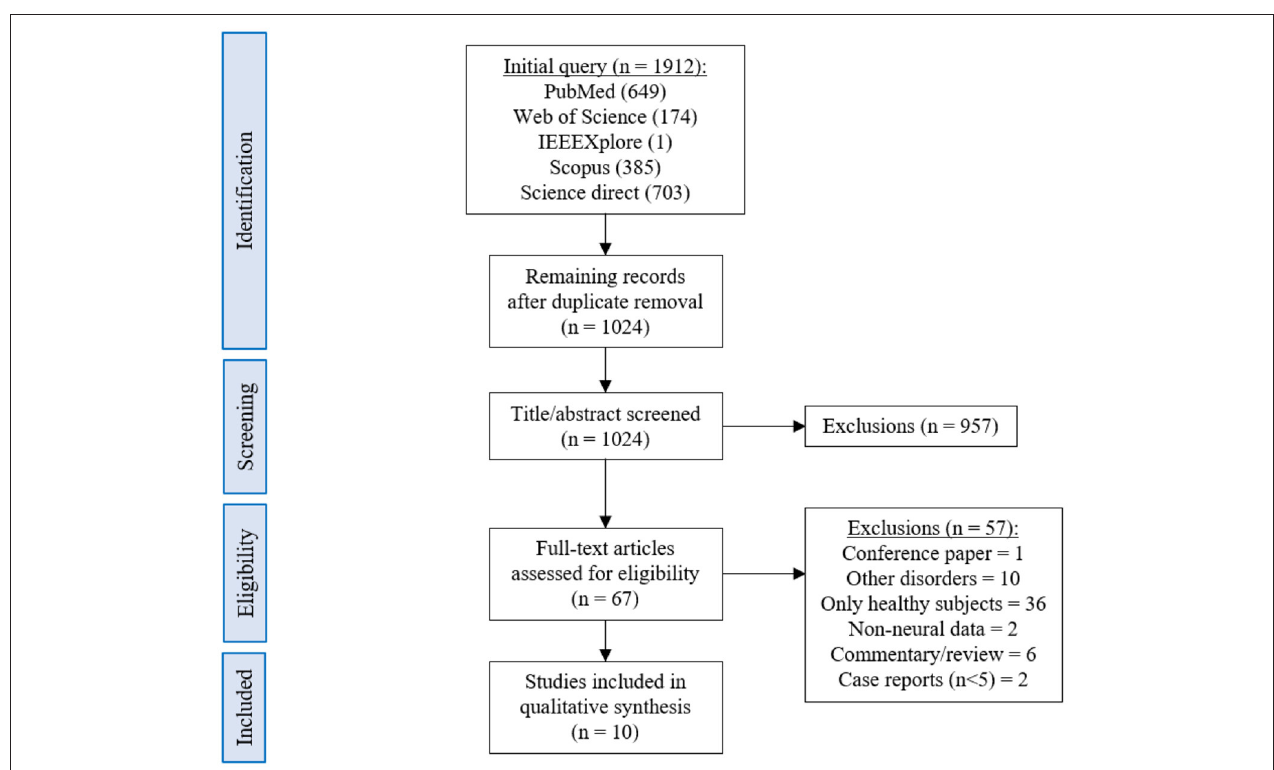
FIGURE 1 | PRISMA flowchart describing the literature